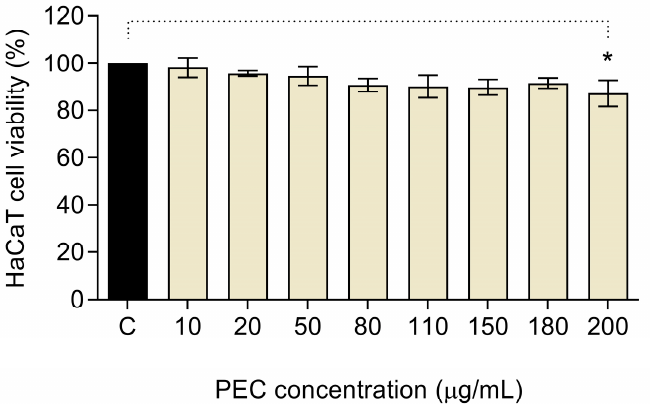
Figure 1. Cytotoxic activities of persimmon byproduct extract (PEC) on human keratinocytes (HaCaT) cell line. PEC treatment at 200 µg/mL provoked a slightly significant reduction on viability (* p < 0.05, ns p > 0.05, ANOVA, and Dunnett’s post hoc test).